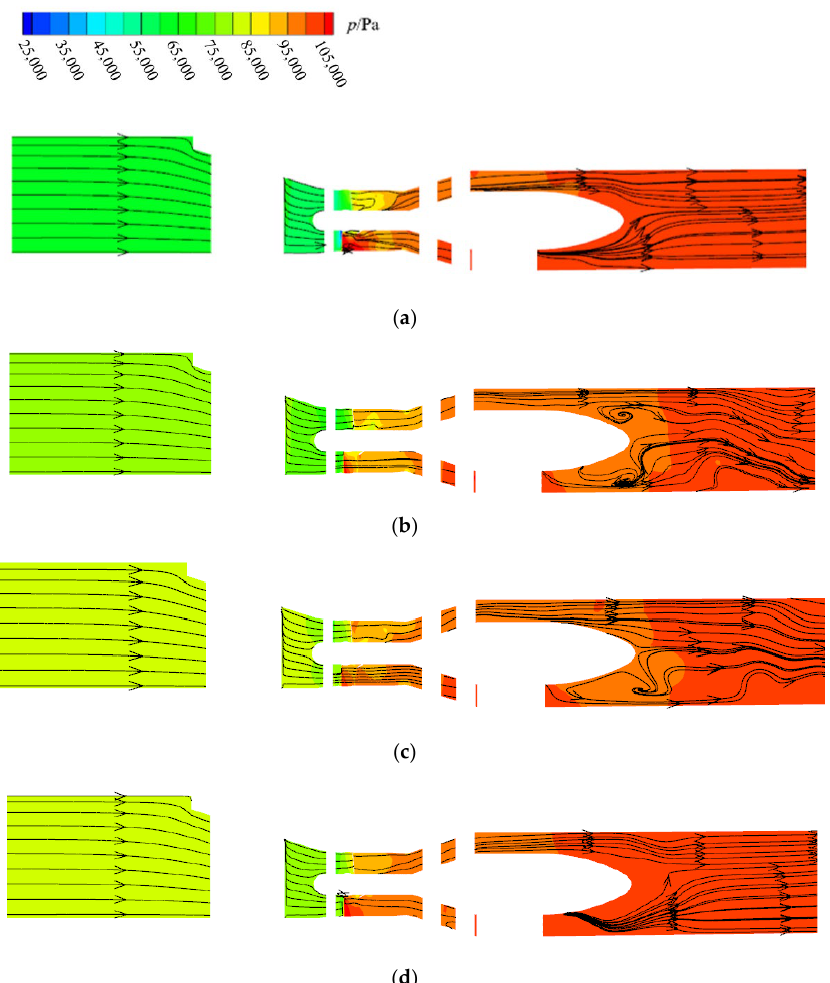
Figure 9. Streamline and pressure contours in horizontal plane of the pump at different times: ( a ) t = 0.5 s; ( b ) t = 1.5 s; ( c ) t = 2.0 s; ( d ) t = 3.0 s.